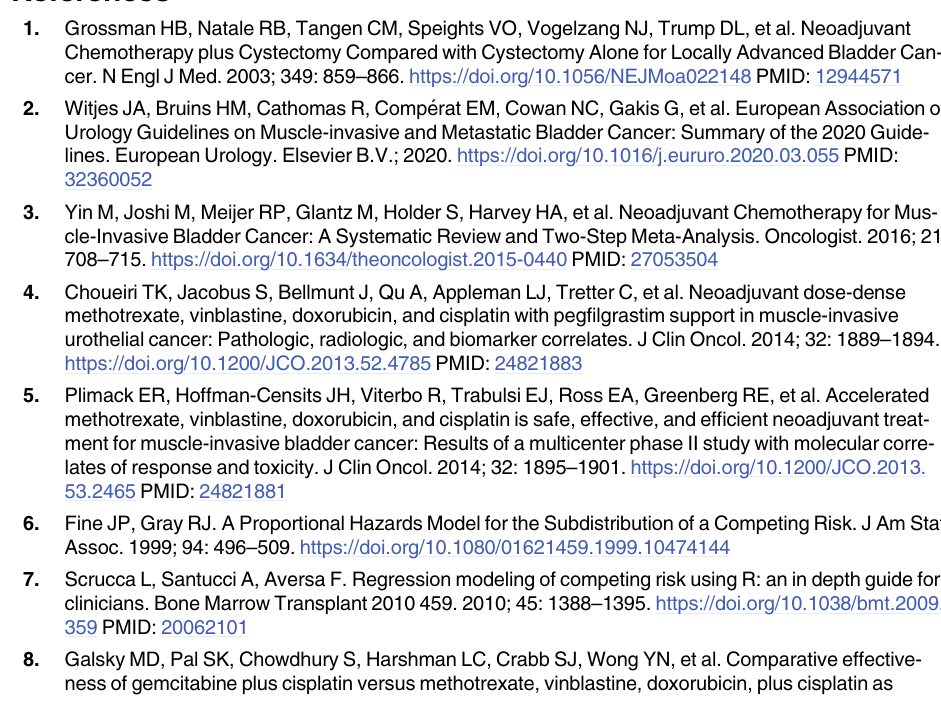
S5 Table. Univariable, multivariable and propensity-weighted competing risk model for cancer